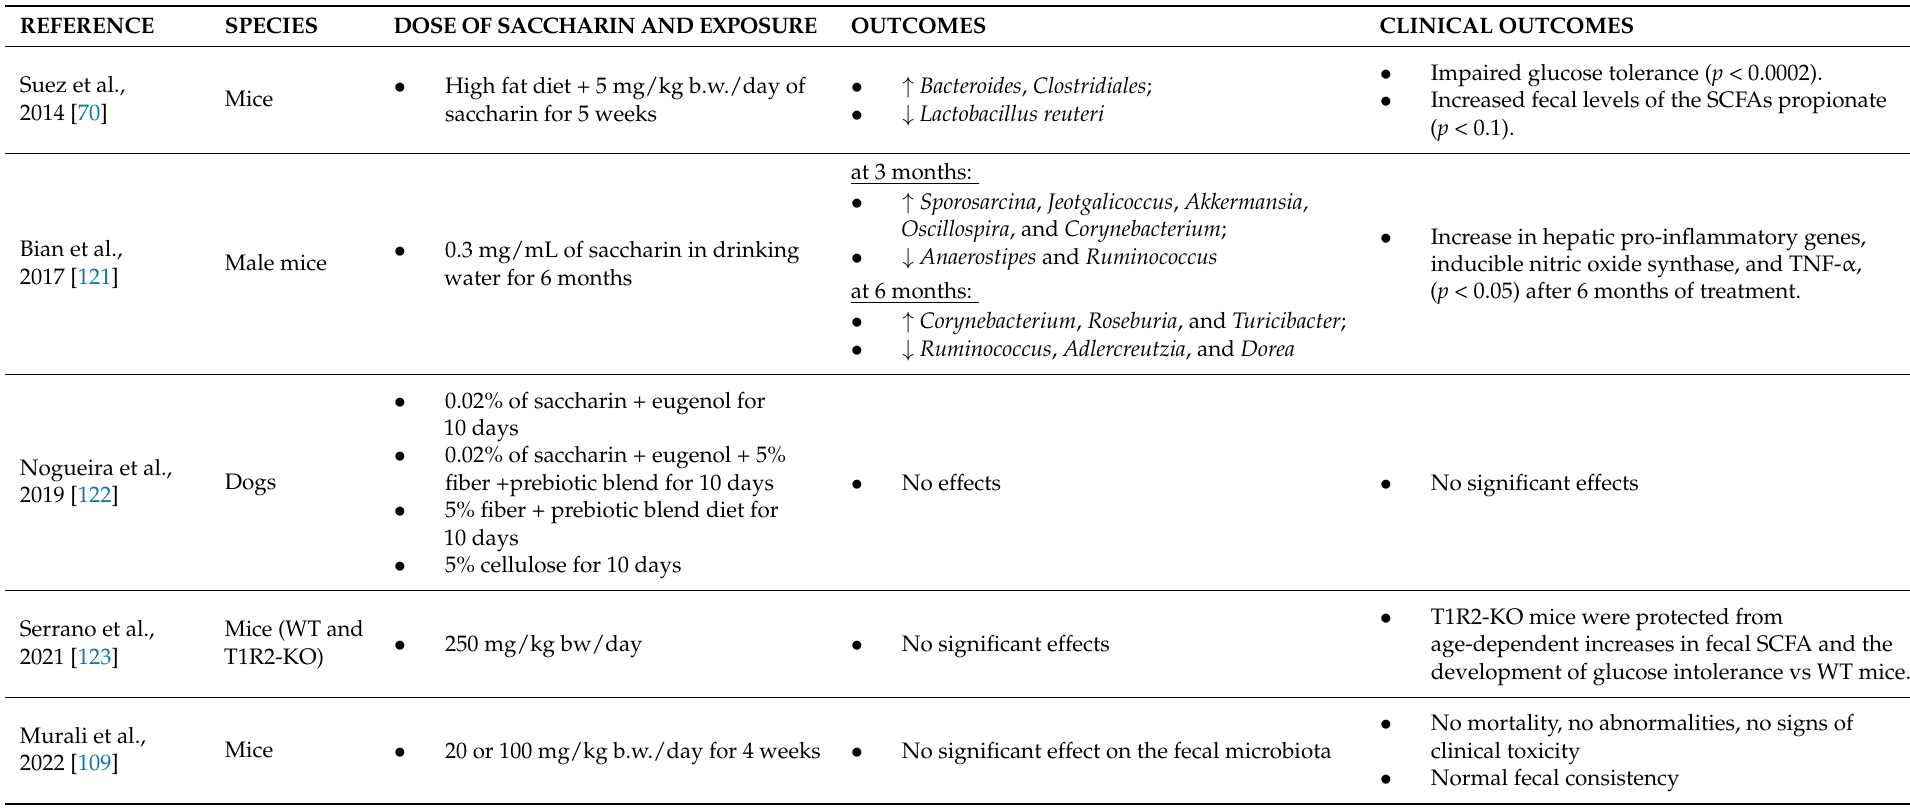
Table 5. Studies on the effect of saccharin on the gut